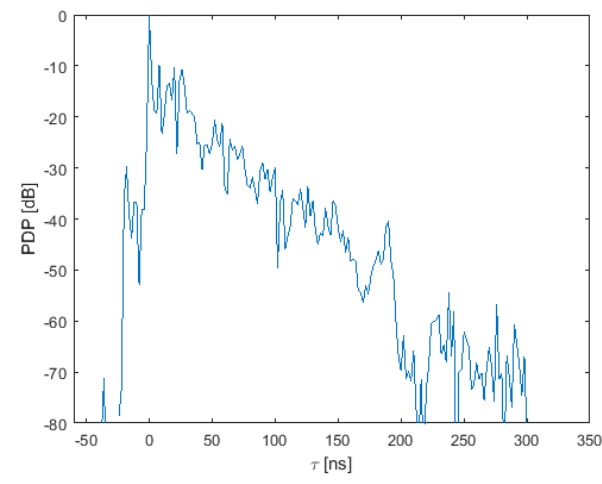
Figure 15. APDP of the alley scenario.